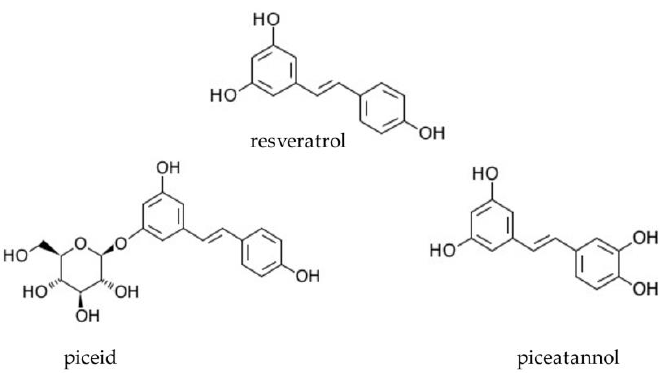
Figure 1. Chemical structure of resveratrol and its derivatives, piceatannol and piceid.